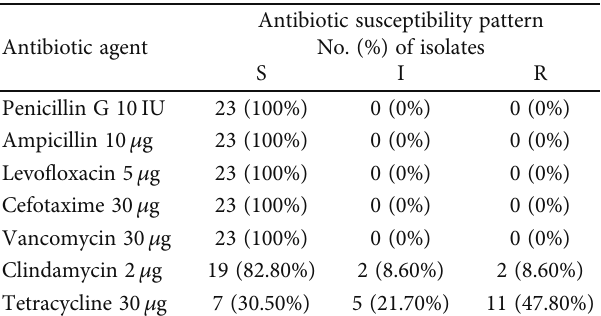
Table 2: Antibiotic susceptibility pro fi le of the 23 vaginal GBS isolates from Yemeni pregnant women in Sana ’ a